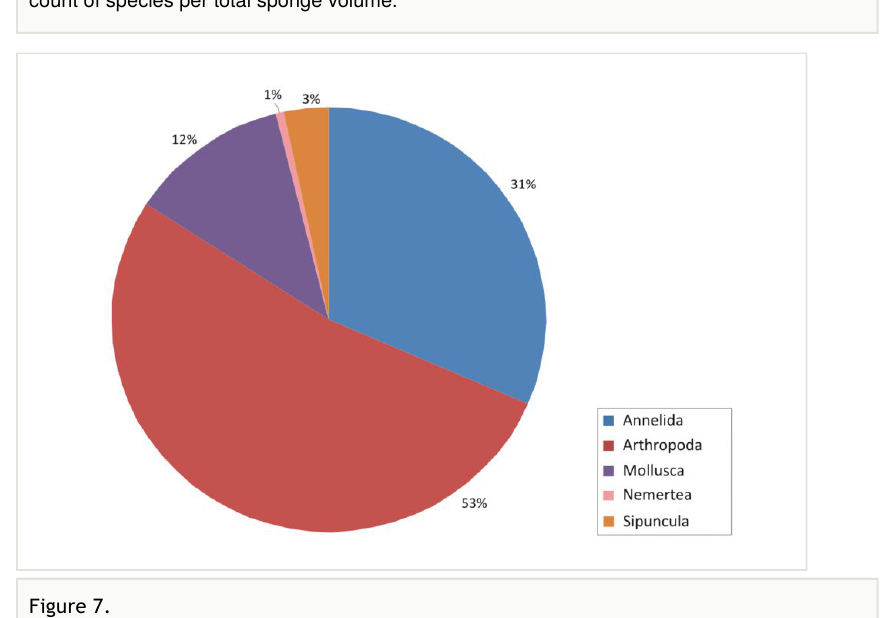
Figure 7. Percentages of main phyla in the summer samples of Greece, as calculated based on the individual count of species per total sponge